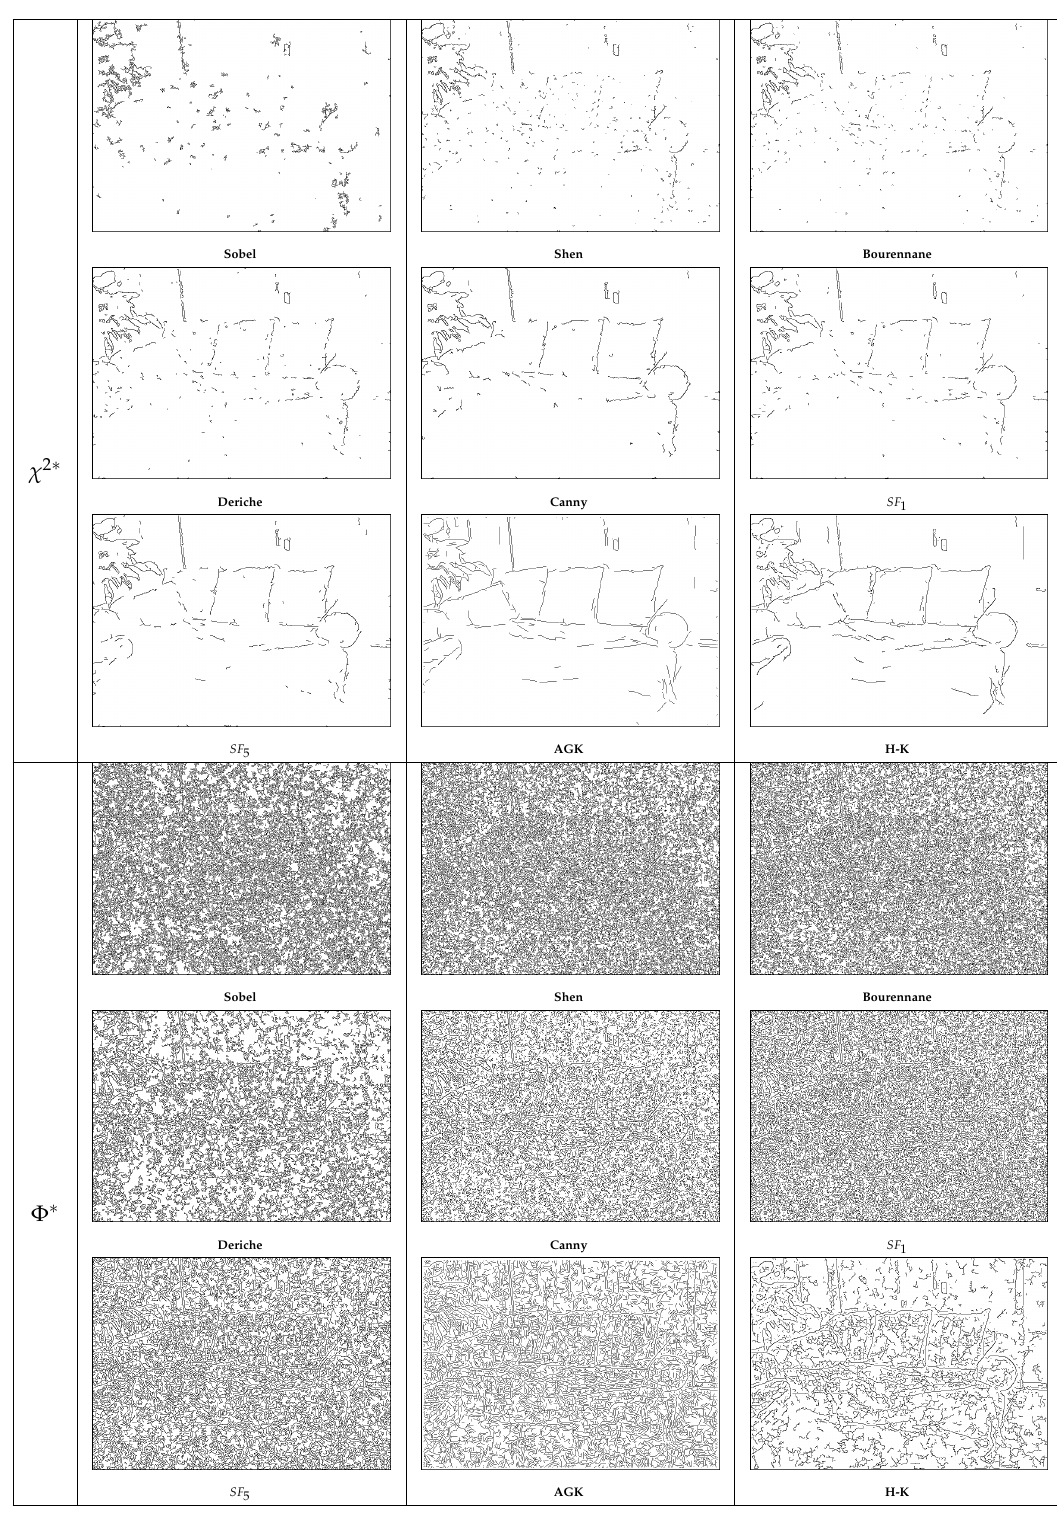
Figure 22. Ideal segmentations for several edge detectors on image 109, PSNR = 14